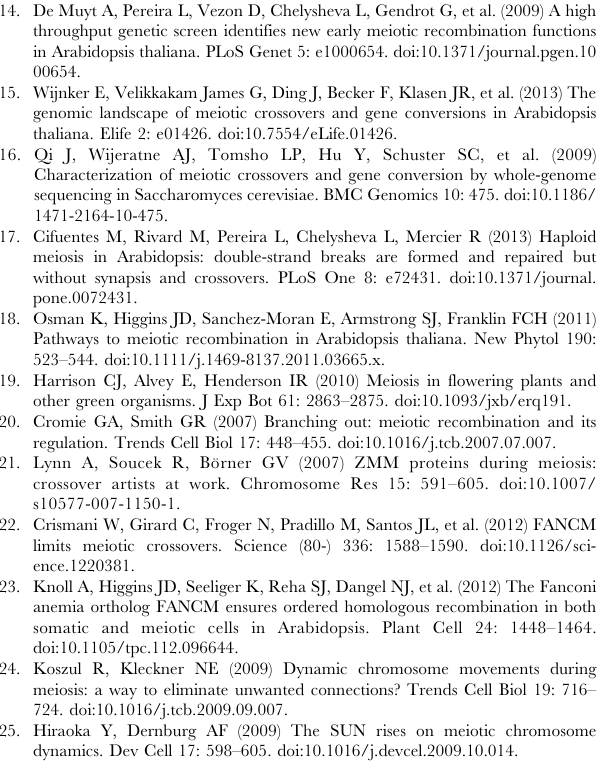
Table S2 PCR Primers used in this